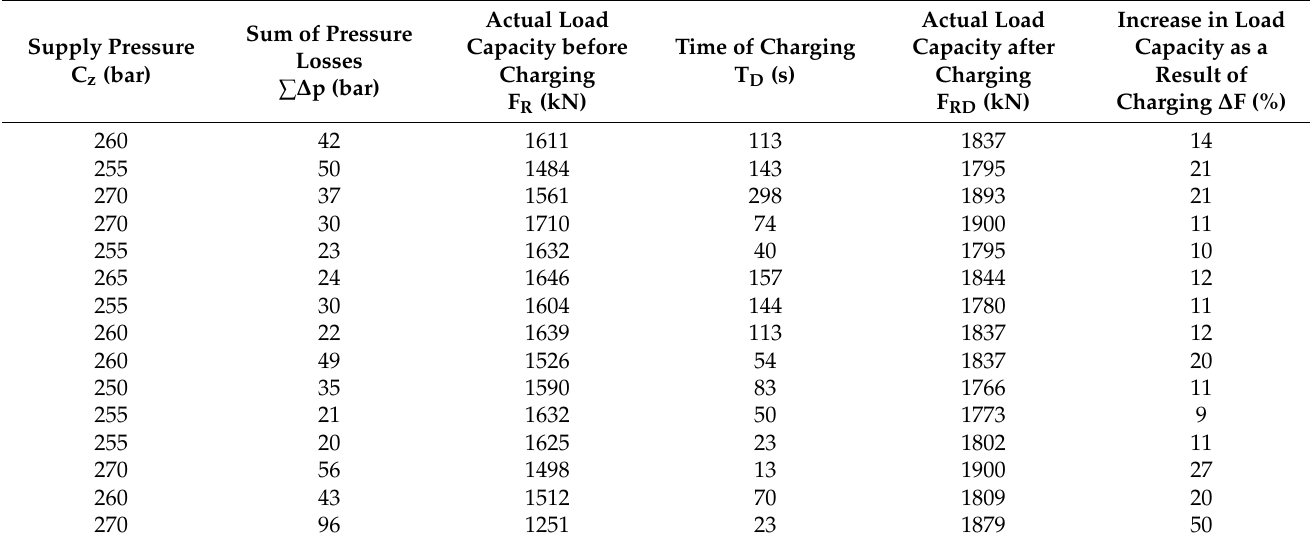
Table 3. The values obtained based on the research carried